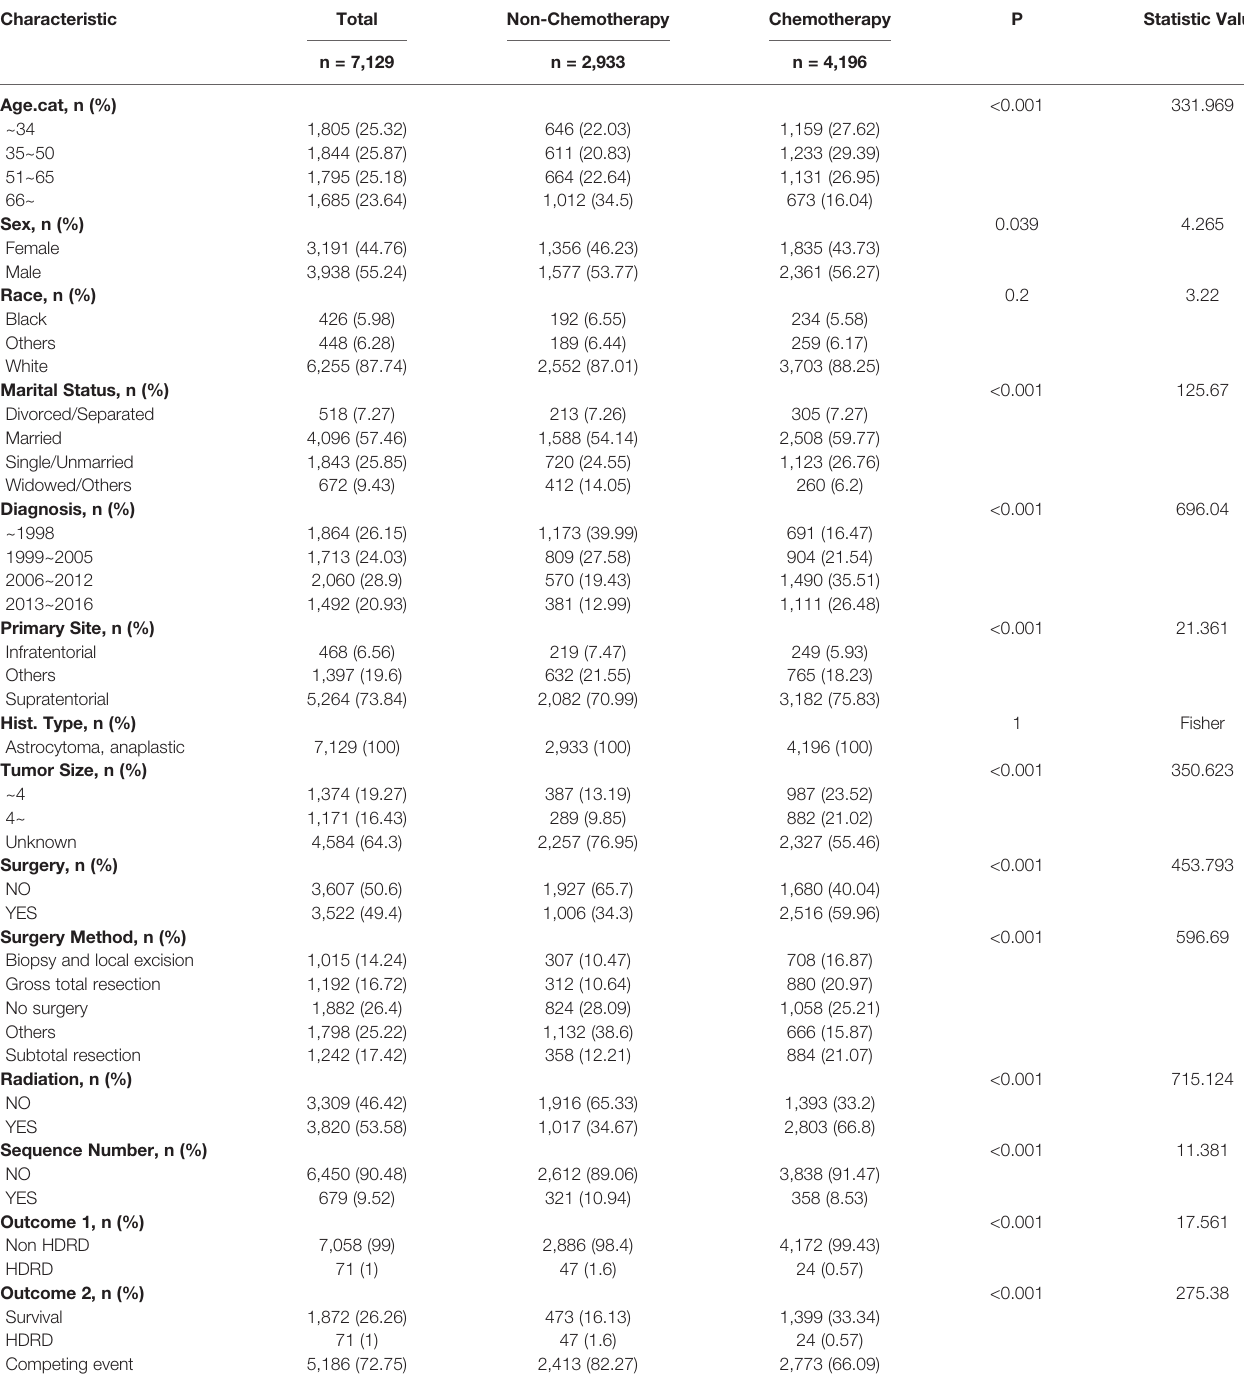
TABLE 1 | The demographic characteristics of anaplastic astrocytoma patients before PSM.